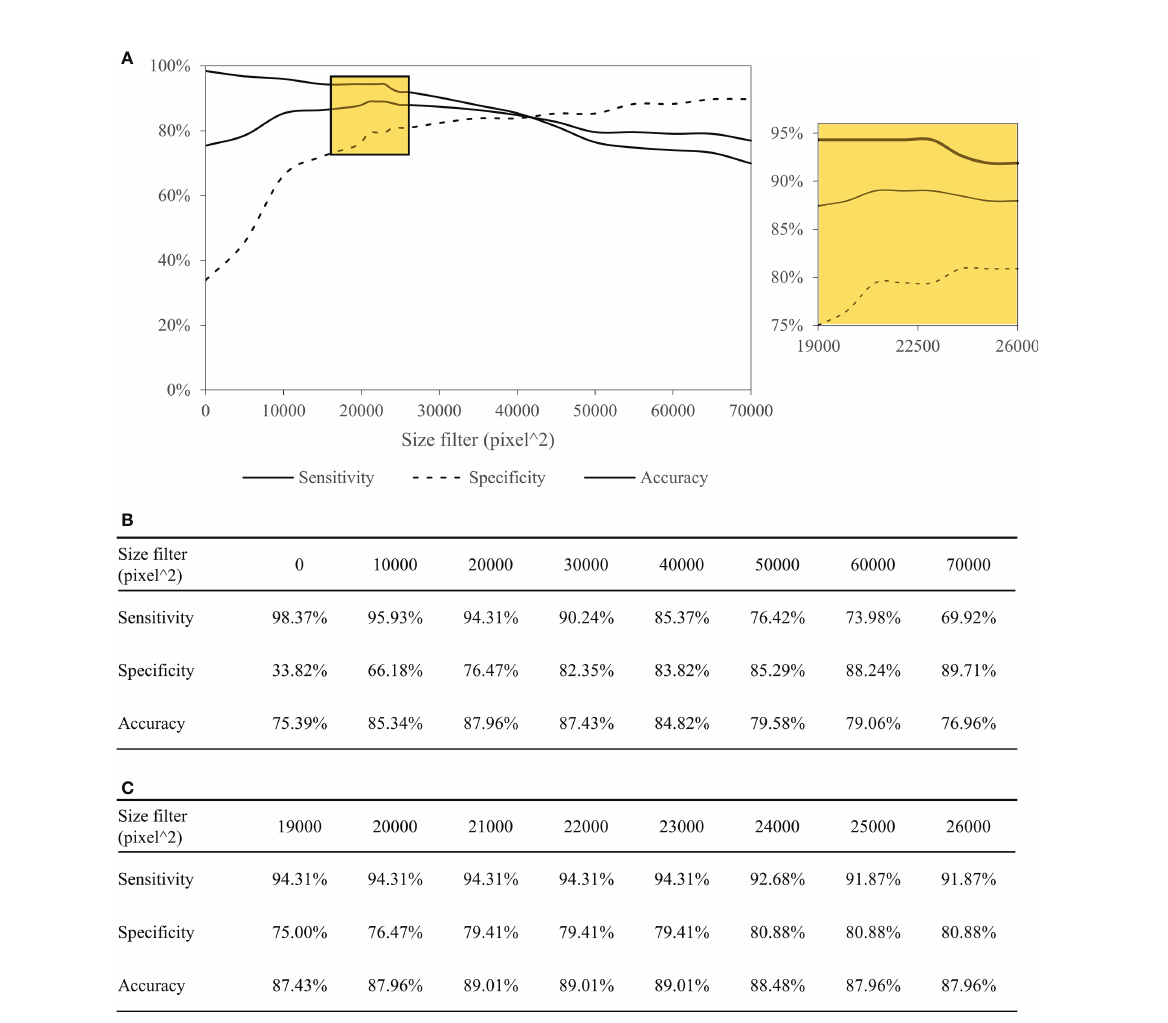
While the pixel-wise resolution of the Domain KEY algorithm allowed detecting the presence of PNI at a fi ne level of detail, noisy signals originating from small-sized objects were a potential source of confounding. This issue was addressed with the application of a size fi lter (cutoff: 21,632 pixel^2) during the post-processing phase. Under these circumstances, the limit of detection of our algorithm was of approximately 8 cells.